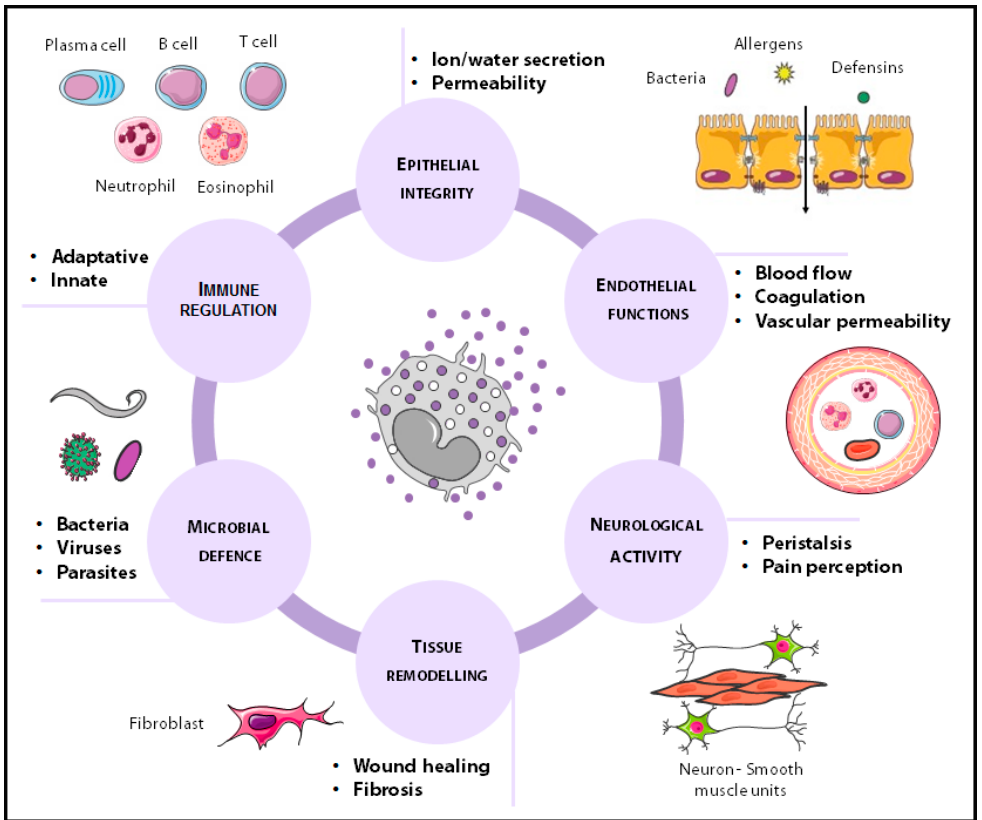
Figure 2. Physiological functions of mast cells in the gastrointestinal tract. Mucosal mast cells play an important role in multiple functions necessary for gut homeostasis, including epithelial, endothelial and neurological functions, tissue transformation, host defence, and immunity.